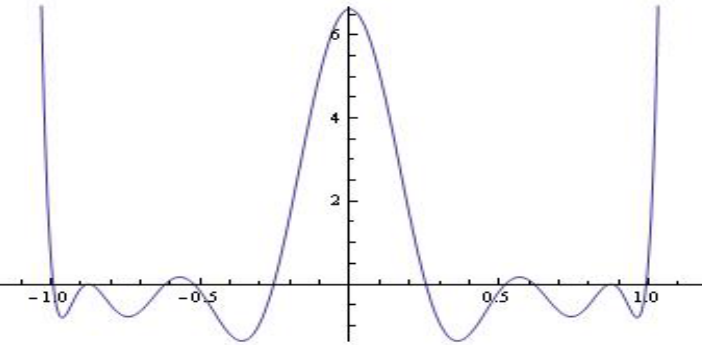
Figure 16. The Melnikov polynomial P ( r 2 ,6 ) .